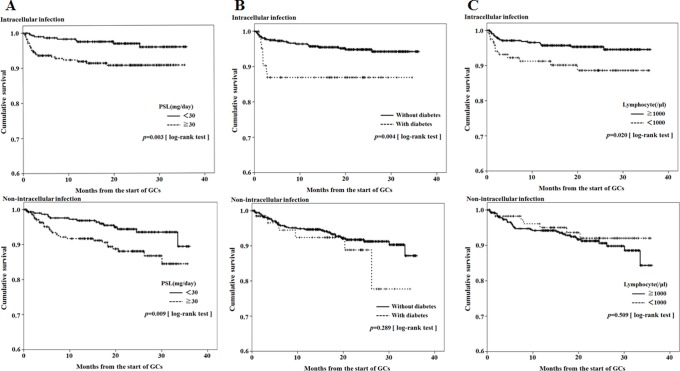
Infection (intracellular or non-intracellular) -free survival curves.
Figure 3A: Cumulative probability of intracellular or non-intracellular infection-free survival for the complete follow-up period between patients receiving high-dose of GC (≥30 mg/day) and those not receiving high-dose of GC. 3B: Cumulative probability of intracellular or non-intracellular infection-free survival for the complete follow-up period in patients with or without diabetes at time of presentation. 3C: Cumulative probability of intracellular or non-intracellular infection-free survival for the complete follow-up period in patients with or without lymphocytopenia (<1000/μl) at time of presentation.